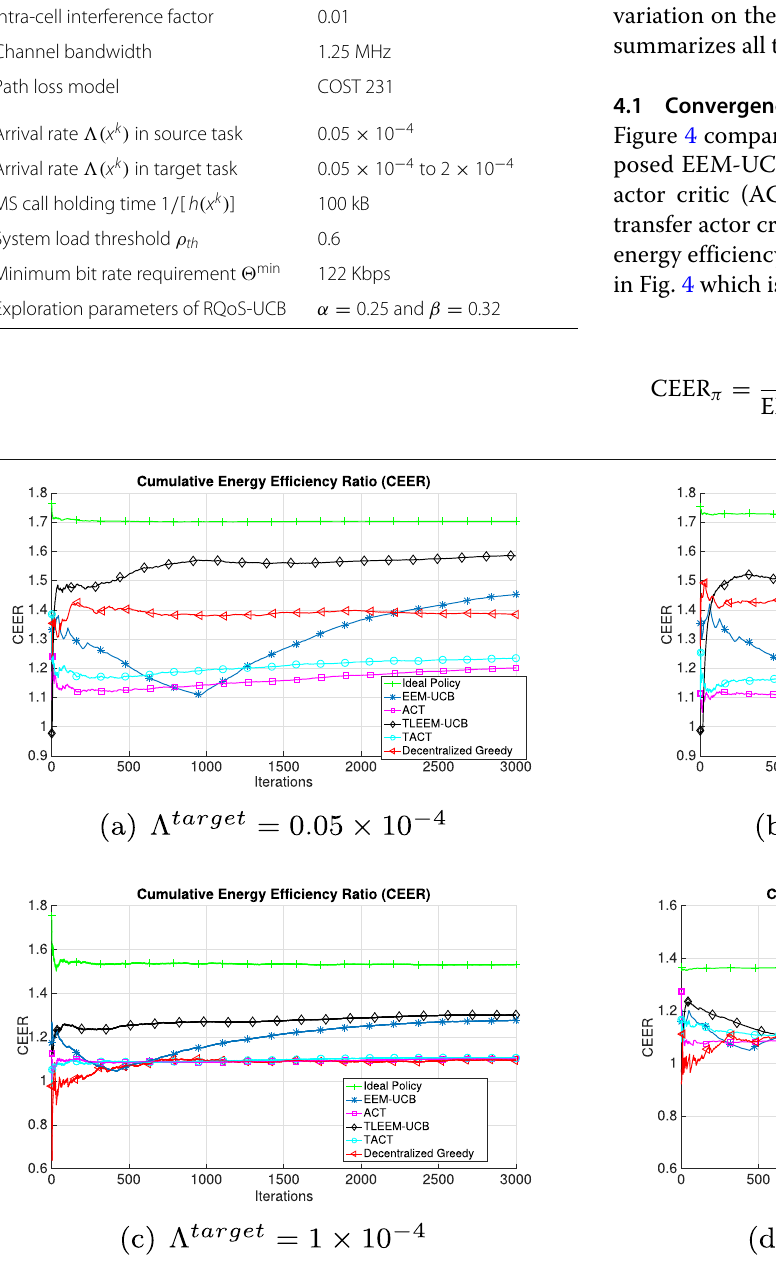
Fig. 4 Convergence rate comparison under various homogeneous Poisson point process traffic intensity with transferred knowledge estimated from a source task with traffic intensity (cid:2) source = 0.05 × 10 − 4 . The figures show the convergence rate, in term of CEER, of the proposed policies, i.e., EEM-UCB and TLEEM-UCB, w.r.t. number of iterations and for several combination of source and target traffic intensities. Source intensity is fixed to (cid:2) source = 0.05 × 10 − 4 while the target intensities are (cid:2) target = 0.05 × 10 − 4 ( a ), (cid:2) target = 0.5 × 10 − 4 ( b ), (cid:2) target = 1 × 10 − 4 ( c ), and (cid:2) target = 2 × 10 − 4 ( d ). The figures provide comparison with state-of-the-art